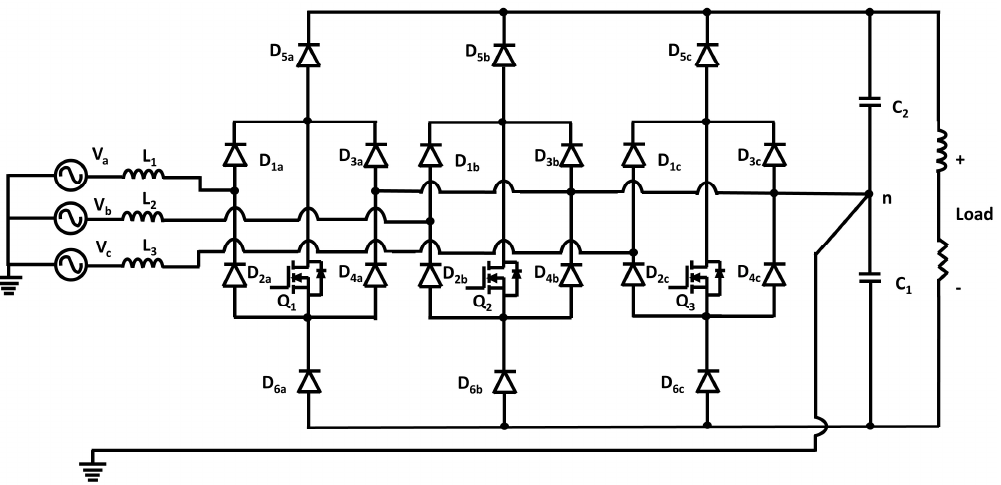
Figure 8. Three-phase Vienna rectifier.